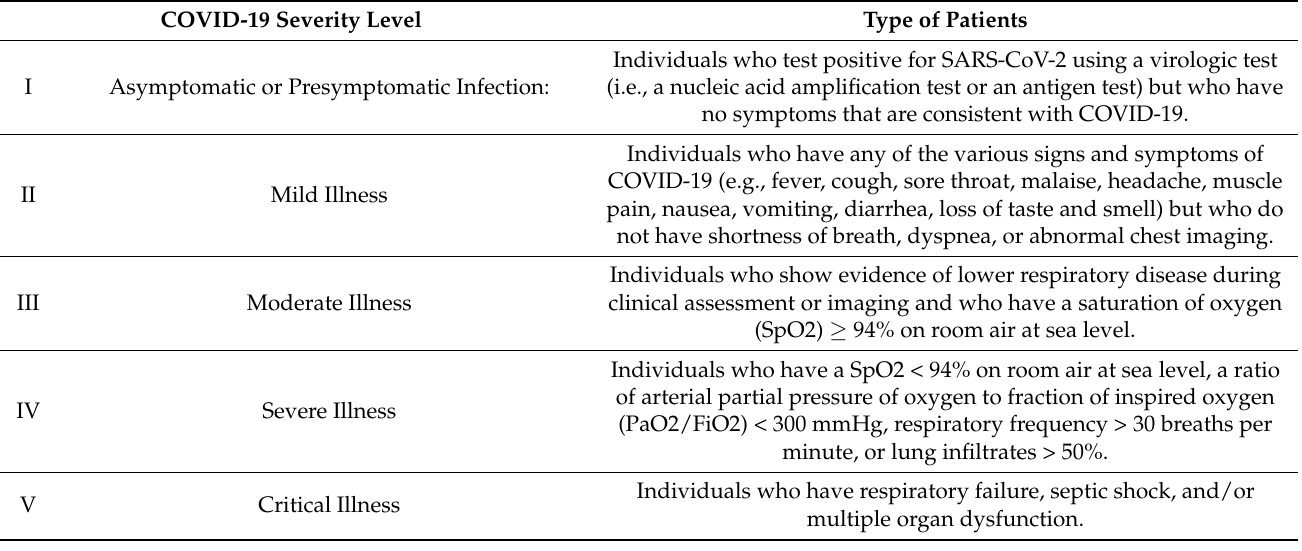
Table 1. Clinical level of COVID-19 disease